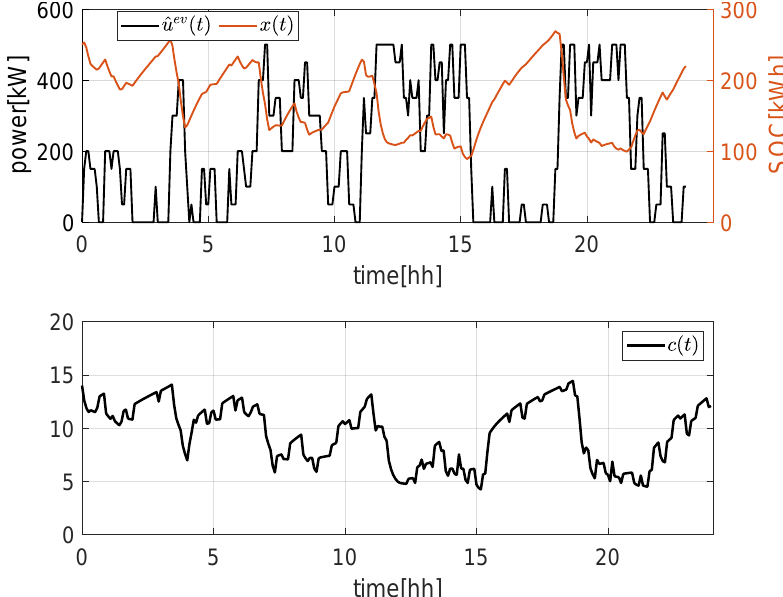
Figure 4. Evolution of cost c ( t ) based on PEVs’ power demand and ESS SOC.